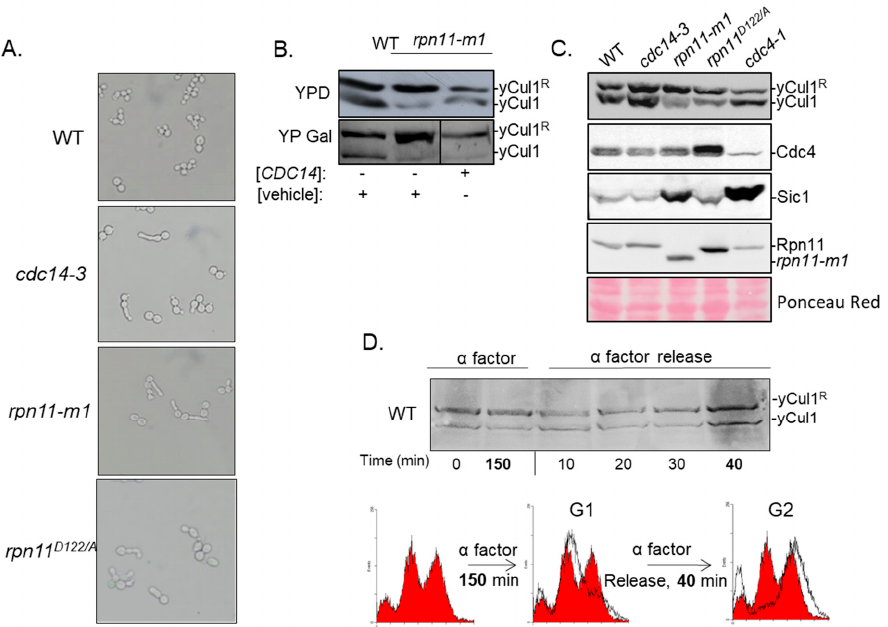
Figure 2. Cell cycle does not determine yCul1 NEDDylation status. ( A ) WT and mutant yeast strains were grown at 28 ◦ C for 16 h, then shifted to a restrictive temperature of 37 ◦ C for 5 h to enhance cellular phenotypes. ( A ) Cell cycle defects were observed by light microscope (magnification x400). ( B ) The rpn11-m1 mutant cells were grown overnight in ra ffi nose and diluted to 0.5 OD 600 in galactose (YP Gal) to induce the expression of CDC14 or a vehicle plasmid, or in glucose (YPD) for control. The extent of yCul1 modification by Rub1 was examined by immunoblotting of total protein extracts with yCul1 antibody. ( C ) Yeast strains were grown as previously explained ( A ), followed by extraction of total protein extracts used for yCul1 immunoblotting. The accumulation of the short-lived F-box protein Cdc4 and its substrate Sic1 was validated as well. Note that cdc4-1 is a control for decreased endogenous levels of the yCul1 Cdc4 complex. Cdc4 expression shows a negative correlation with the accumulated Sic1. ( D ) WT cells were grown in glucose supplemented by α factor for 150 min for synchronization of the cell cycle in G1. Synchronized cells were washed and were then grown in YPD. Samples were taken before and after synchronization at indicated times and subjected to immunoblotting with yCul1. The cell cycle stage was analyzed by quantitation of DNA content by flow